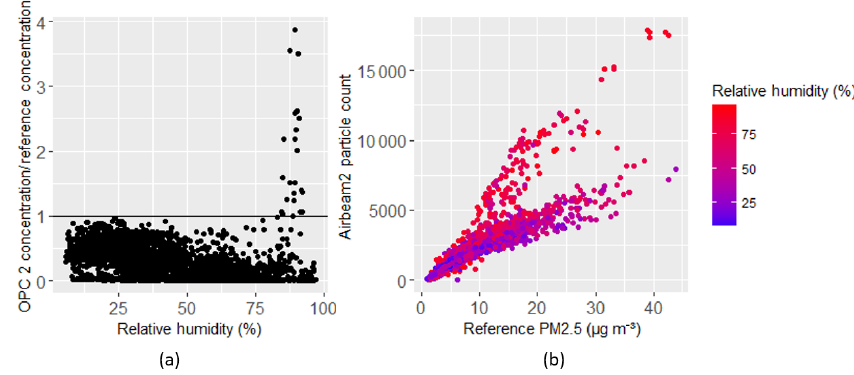
Figure 3. OPC-N2 PM 2 . 5 and relative humidity (a) and hourly average FEM PM 2 . 5 concentration and AirBeam particle count stratified by relative humidity (b) .